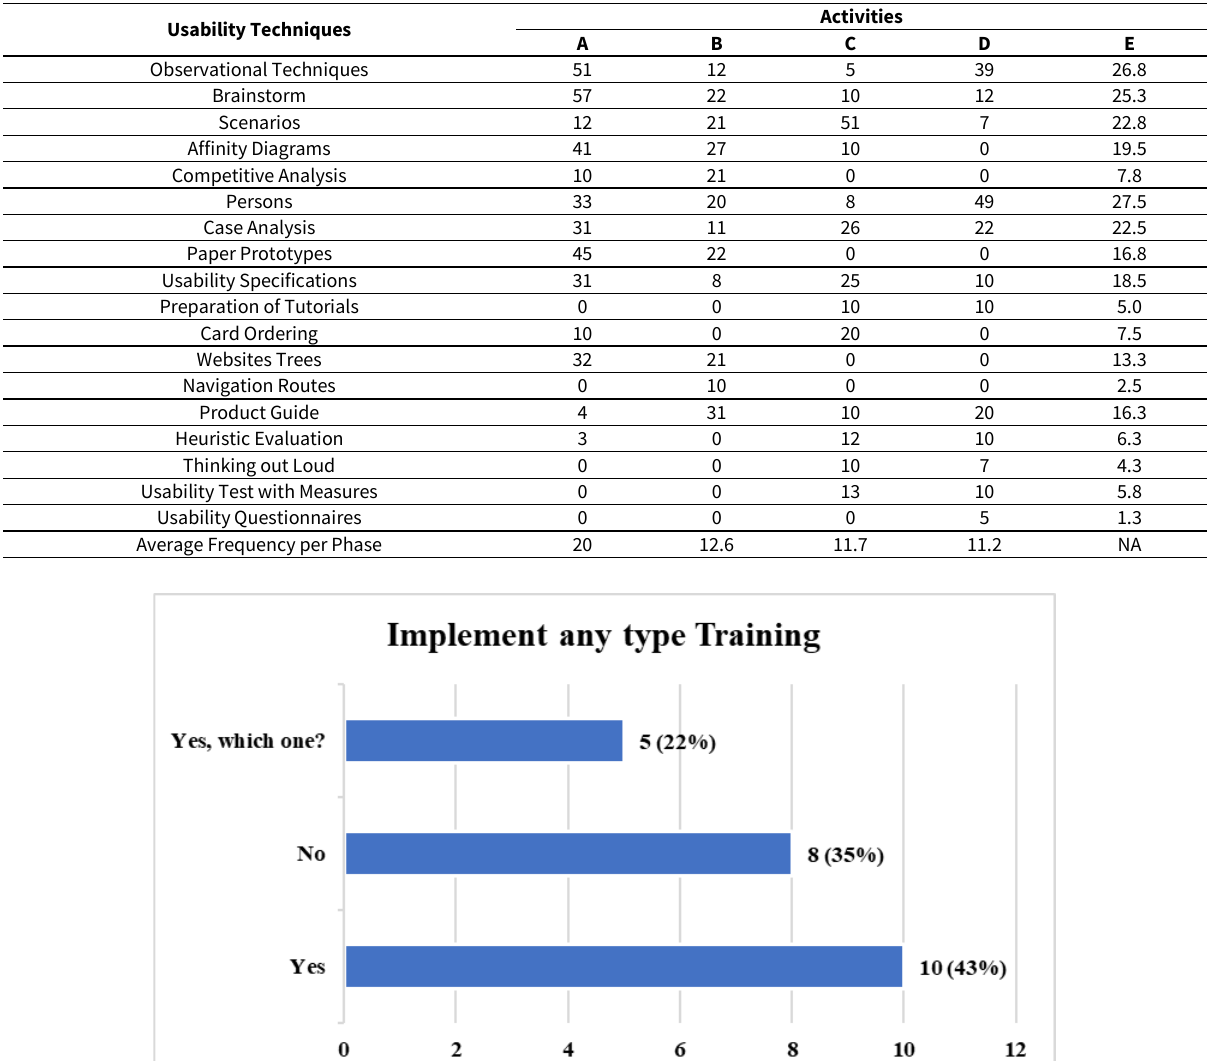
Table 3. Usability techniques most used for software development, in the 22 companies interviewed